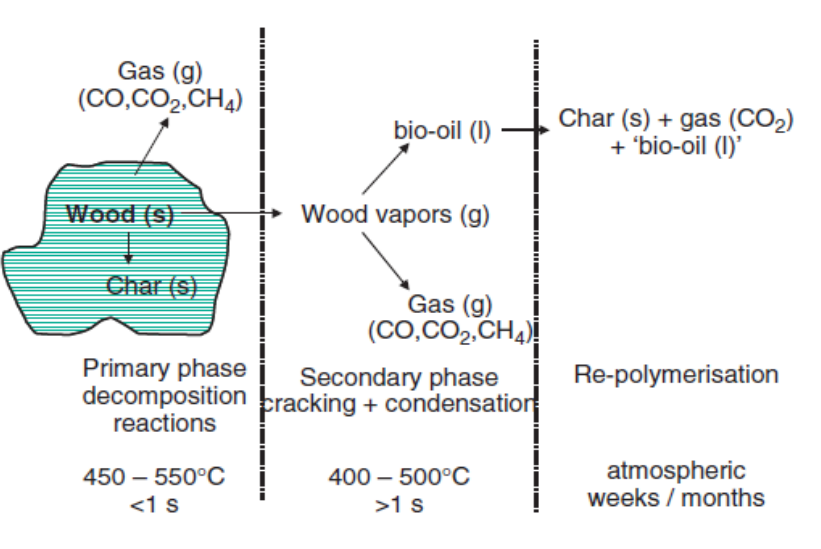
Figure 1. Representation of the reaction paths for wood pyrolysis [29].